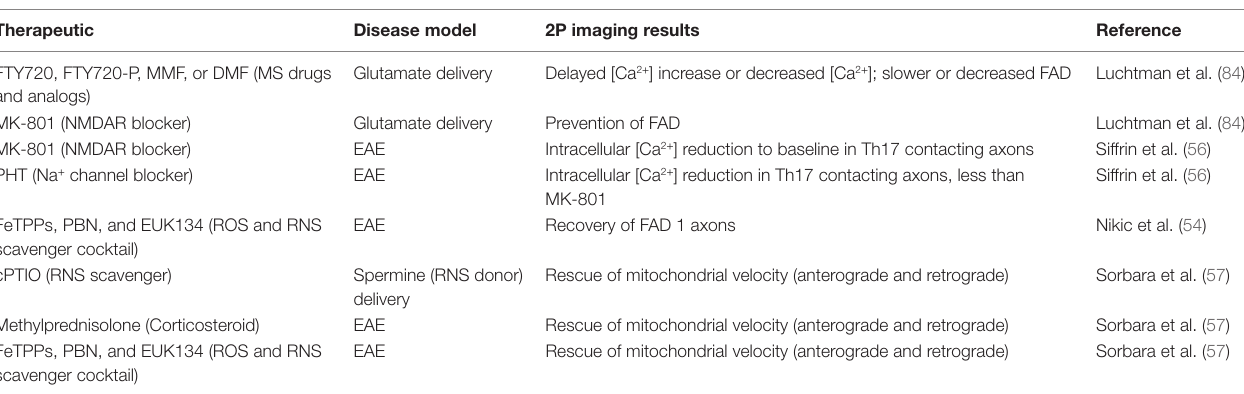
TABLe 1 | Molecular therapeutics for axonal regeneration and results of 2P imaging. Therapeutic Disease